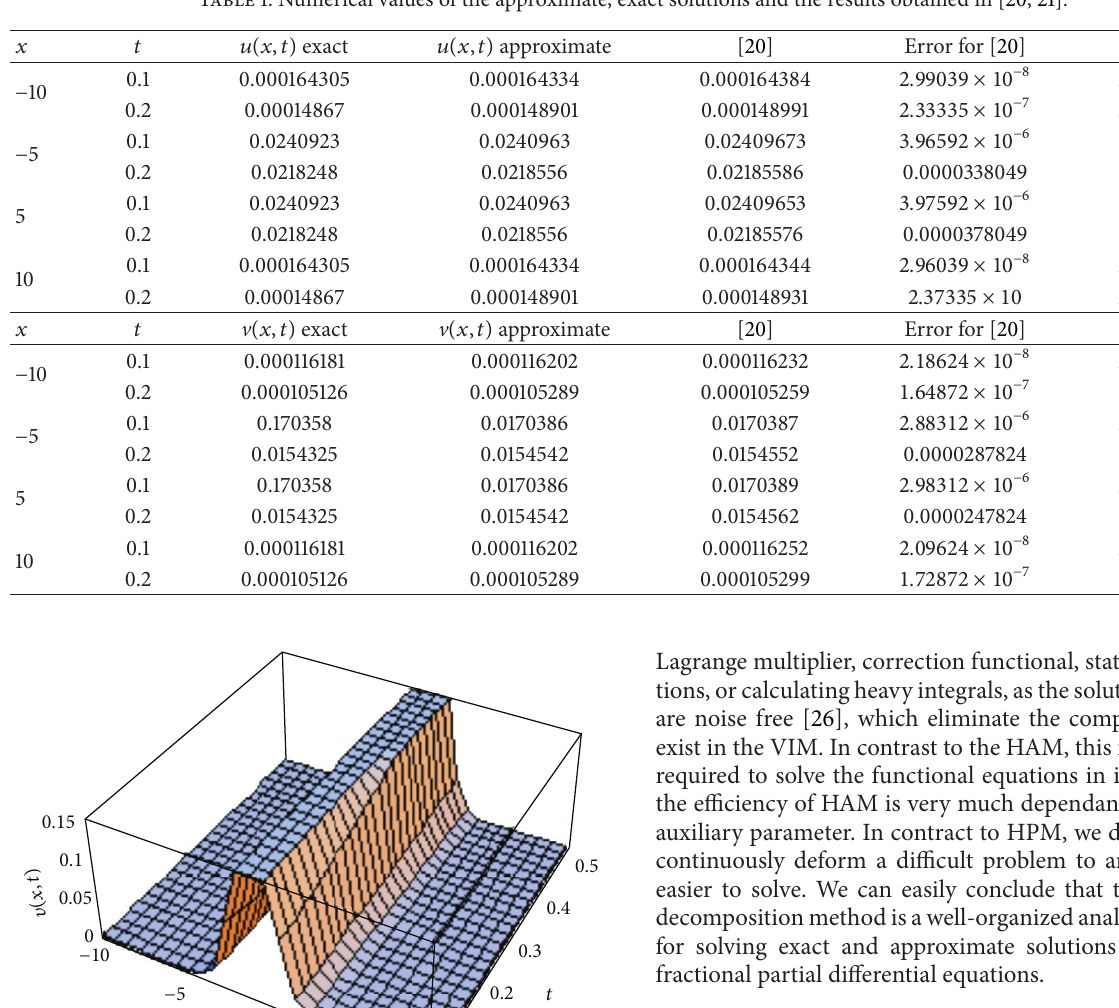
Table 1: Numerical values of the approximate, exact solutions and the results obtained in [20, 21].